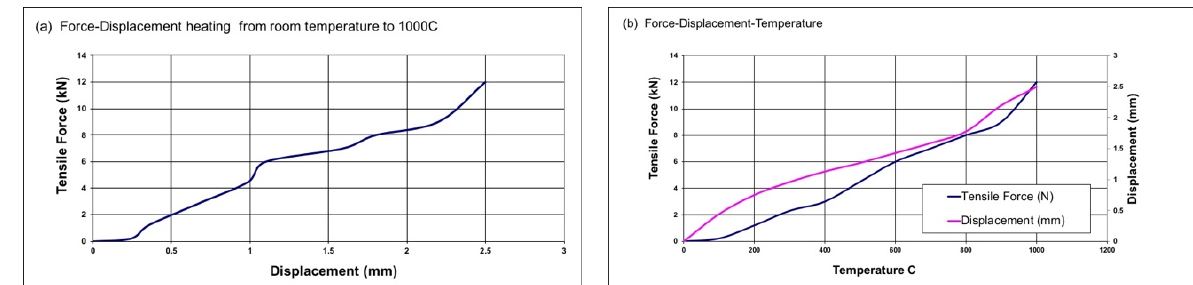
Figure 9. Thermal strain curve of FPC shows ( a ) Force displacement, ( b ) temperature, Tensile force and strain correlations.